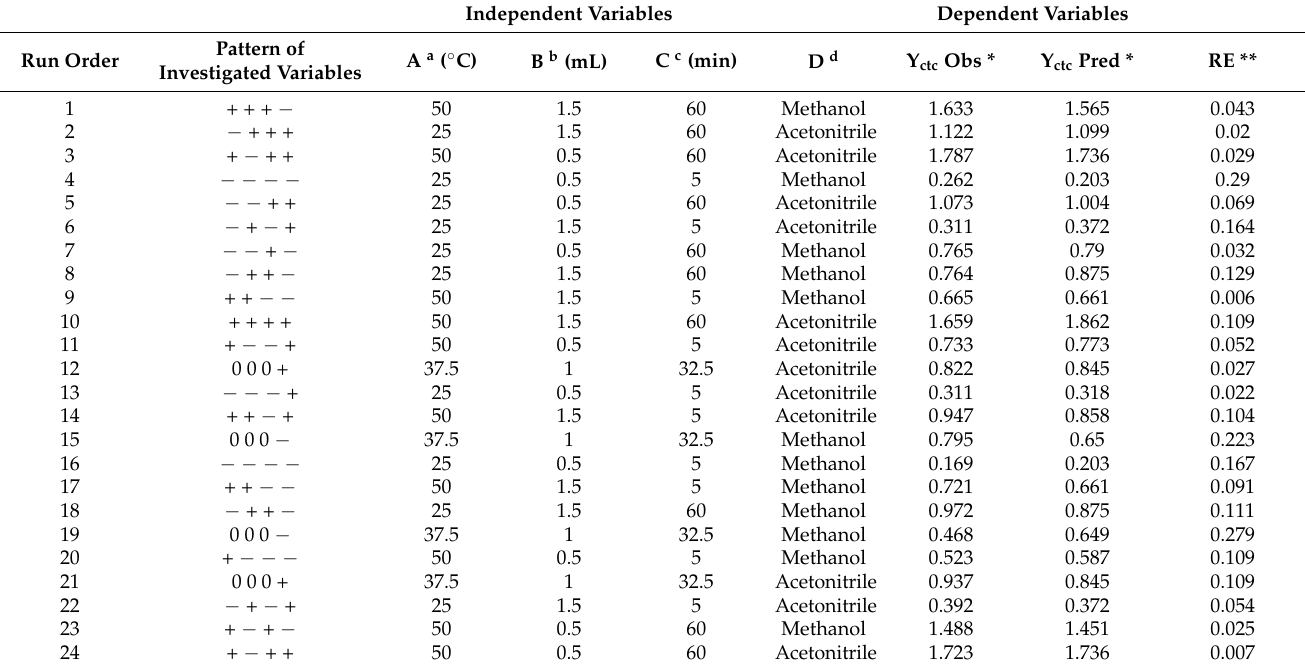
Table 2. Design matrix: the observed and predicted